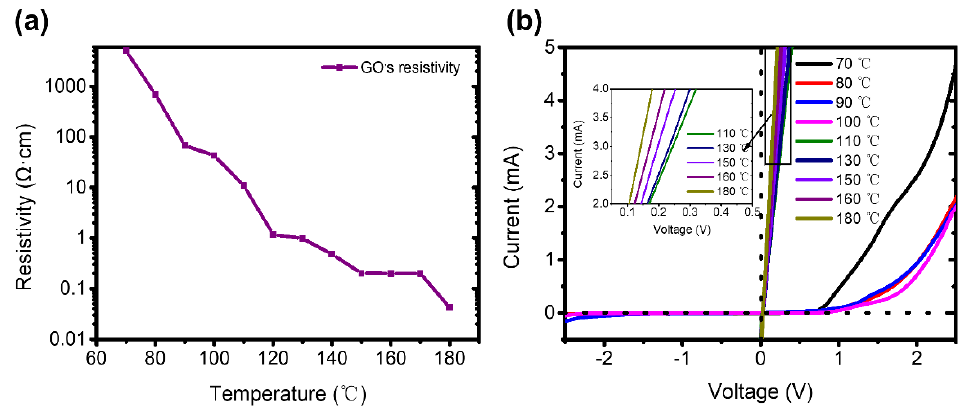
Figure 4. ( a ) Resistivity of GO films with reduction temperature. ( b ) I–V curves of pGO vertical p– junctions prepared with different reduction n junctions prepared with different reduction temperature.